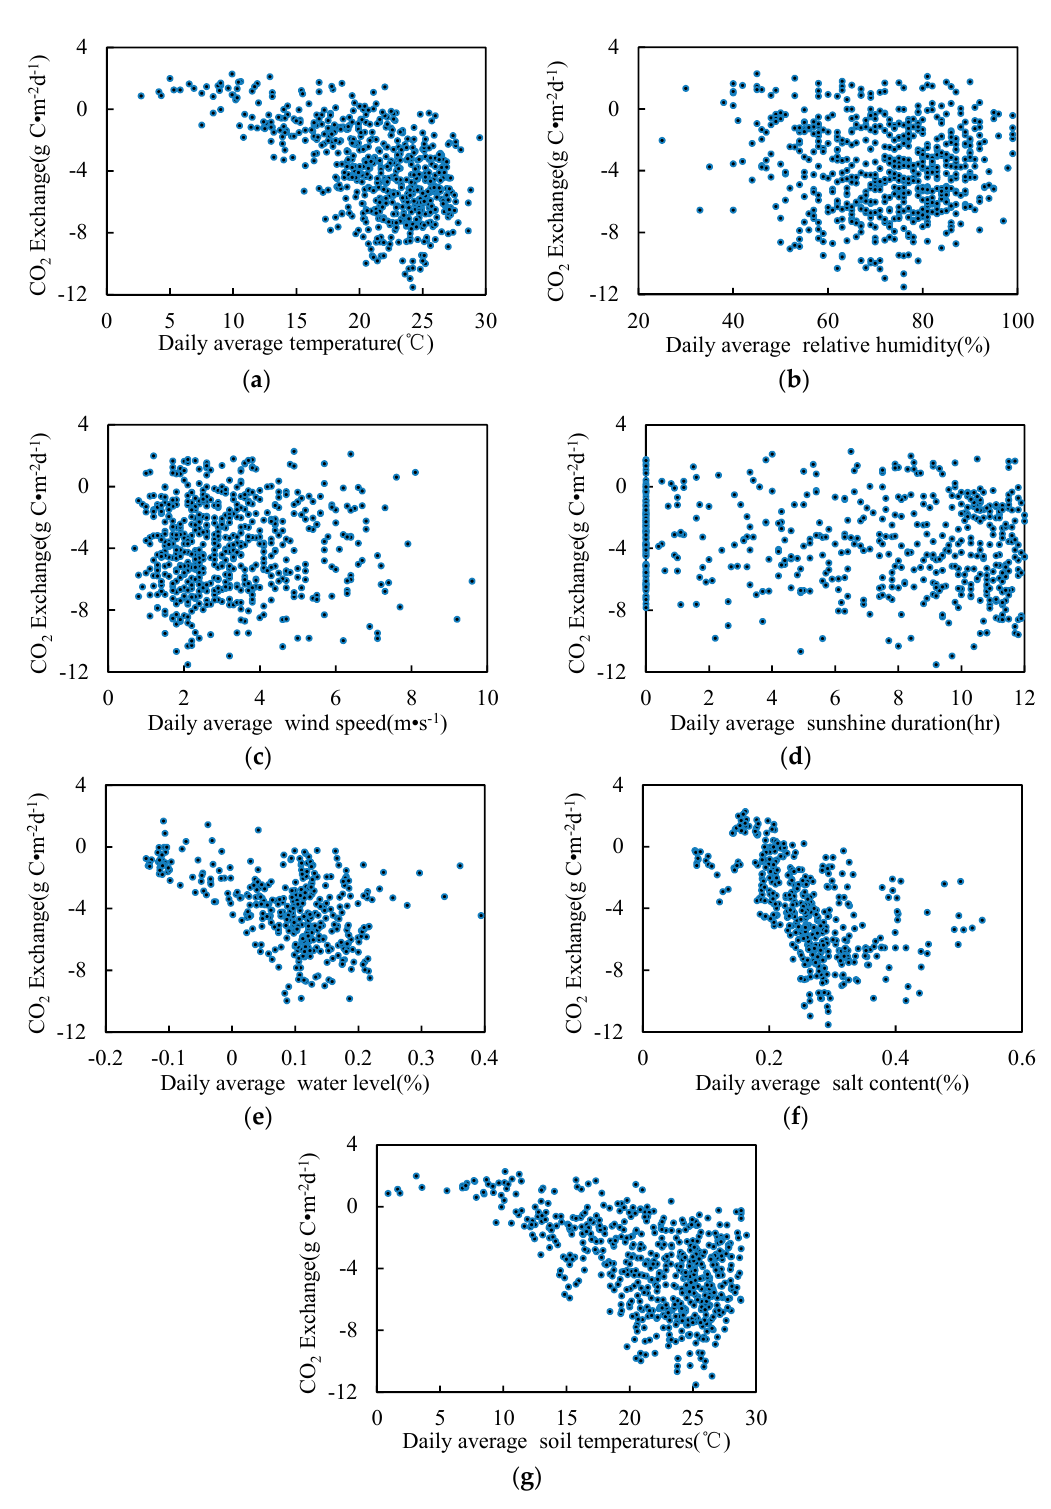
Figure 9. Environmental factors and CO 2 daily exchange in the growing season. ( a ) Temperature; ( b ) Relative humidity; ( c ) Wind speed; ( d ) Sunshine duration; ( e ) Water table level; ( f ) salt content; ( g ) Soil temperature.